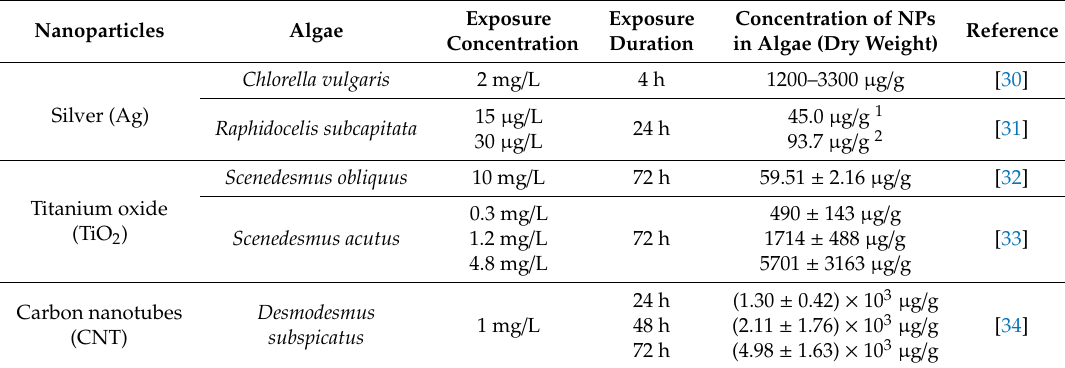
Table 1. Adsorption capacity of algae to nanoparticles